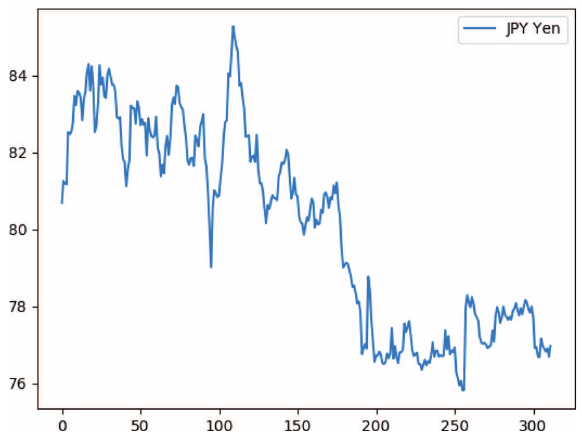
Figure 7: Exchange Rates of Japanese Yen from November 9, 2010 to January 13,